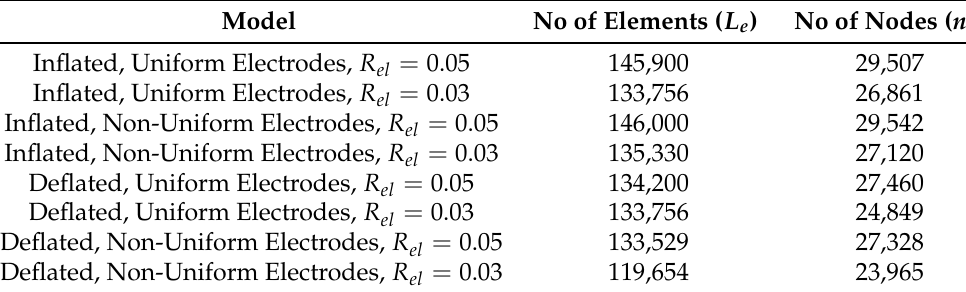
Table 2. Number of tetrahedral elements and nodes of each 3D model